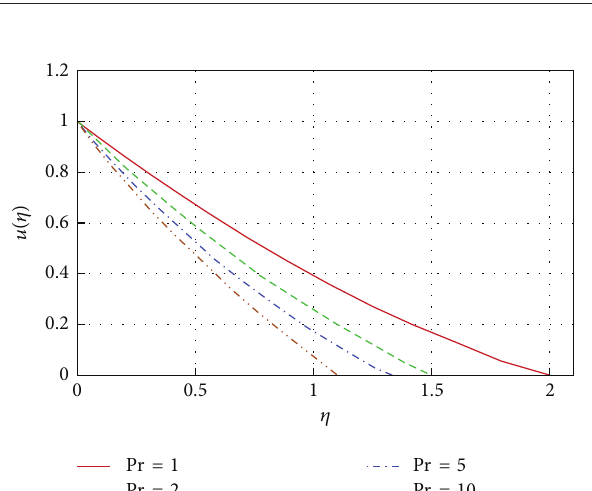
Figure 3: Temperature of Newtonian fluid at the vicinity of stretching sheet for different values of